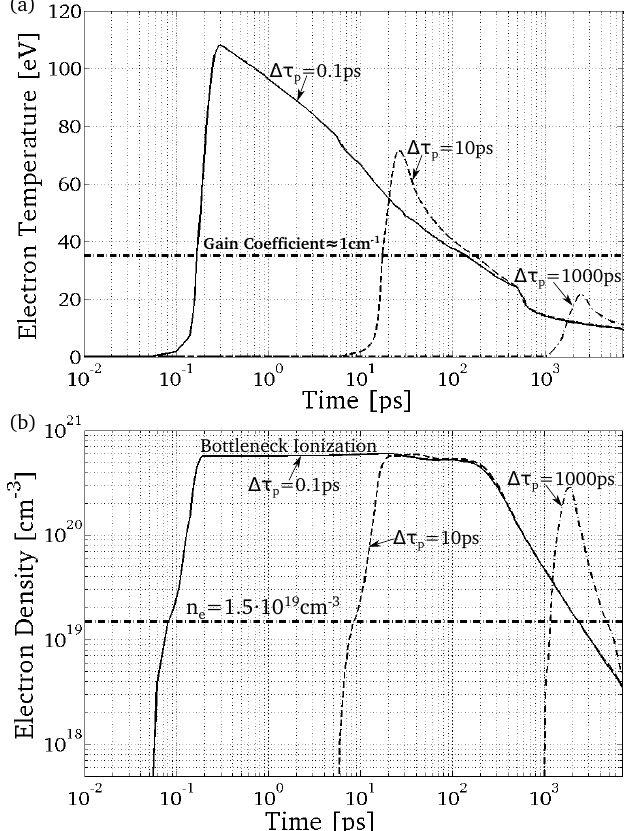
Figure 8. ( a ) Time-dependent electron temperature and ( b ) electron density produced with pulses with durations of 0 . 1 ps, 10 ps and 1,000 ps and energy fluence j